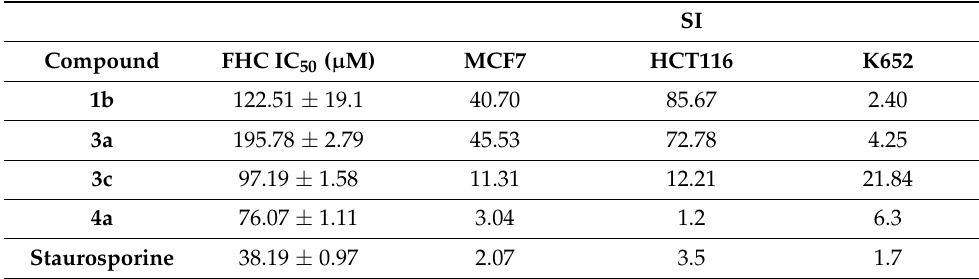
Table 3. Cytotoxicity effect of compound 1b , 3a , 3c , and 4a against normal cells FHC. Data are presented as mean ± standard deviation of three individual